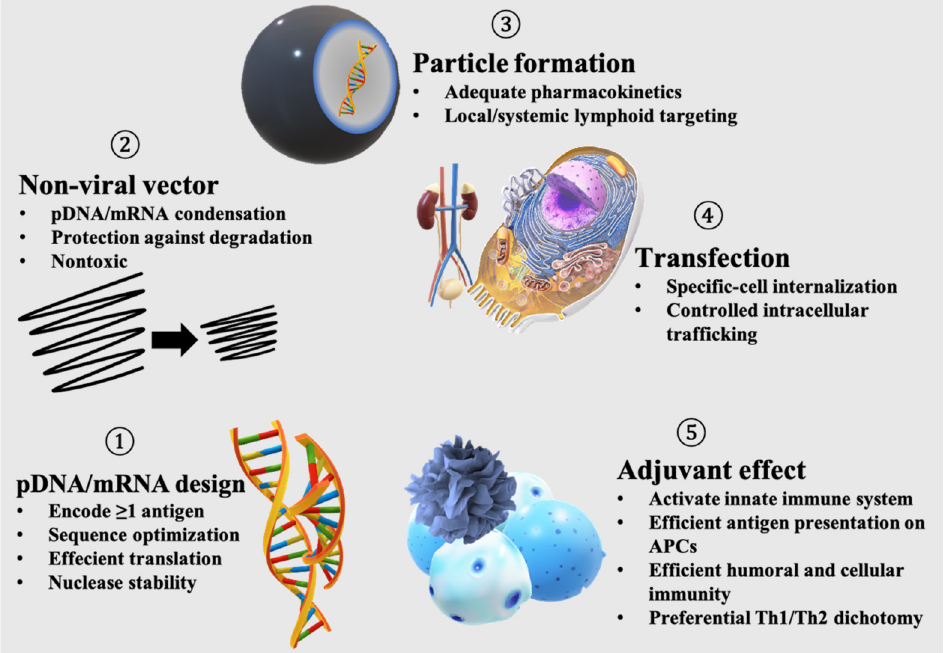
Figure 1. Functions needed for an effective nucleic acid-based subunit vaccine.